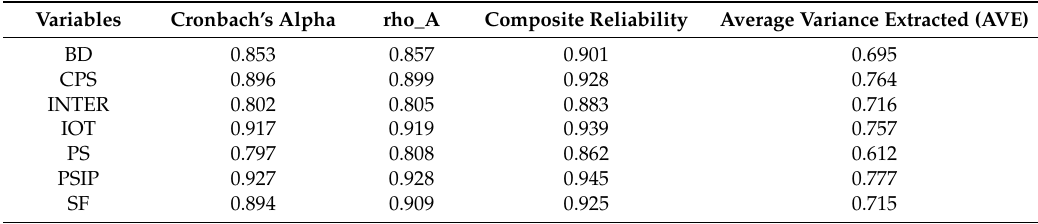
Table 3. Measurement model (results).